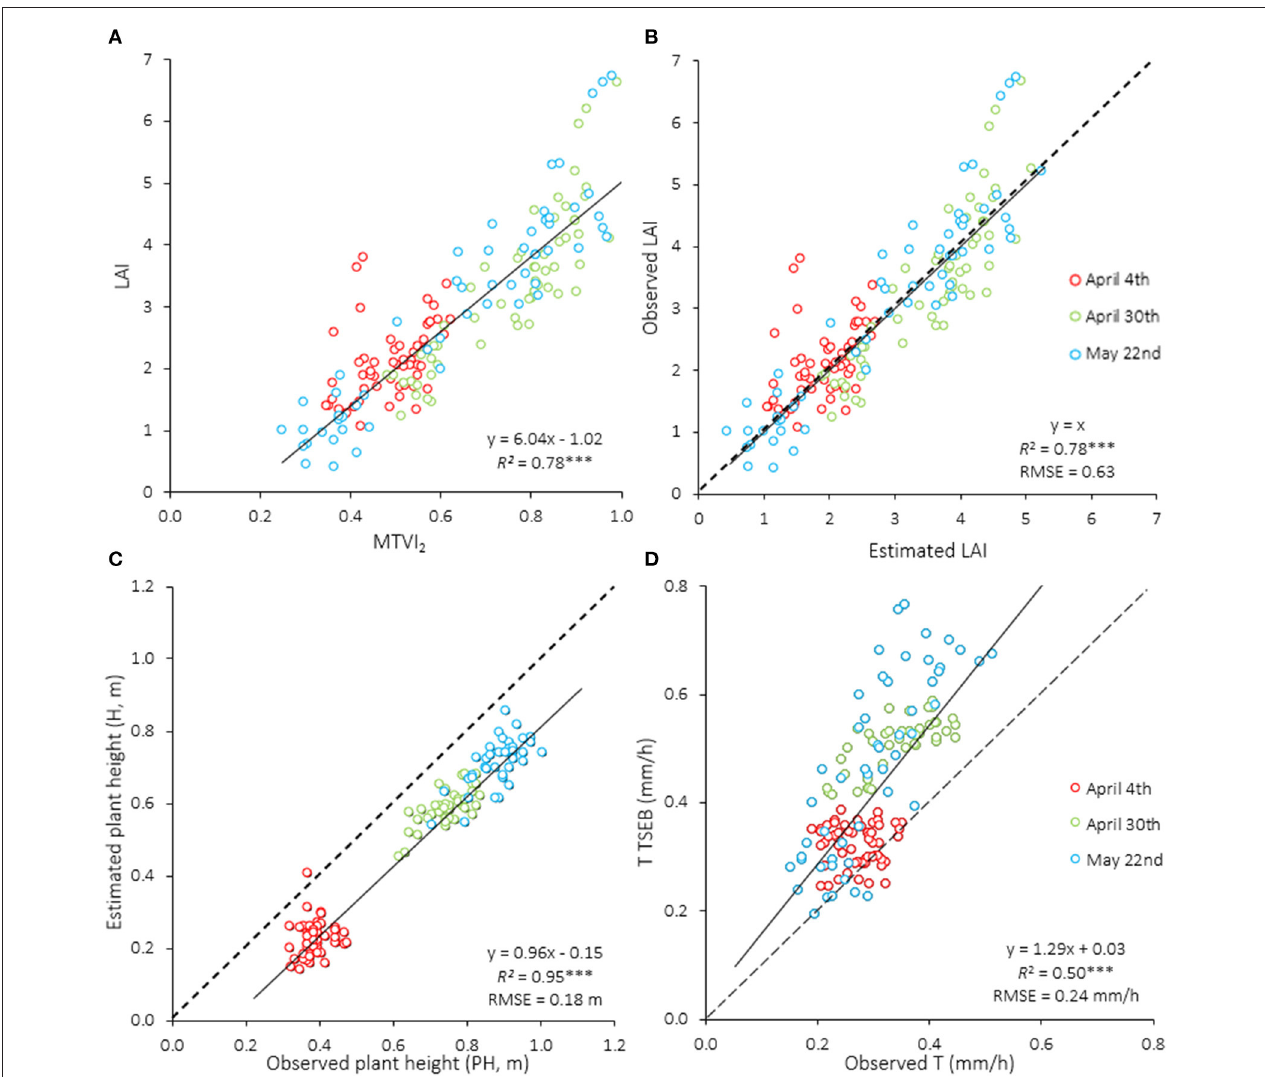
FIGURE 6 | Relationships between (A) leaf area index (LAI) and the MTVI 2 spectral vegetation index, (B) observed and estimated LAI by the MTVI 2 , (C) observed and estimated plant height by the photogrammetric 3D point cloud, and (D) observed leaf transpiration with the IRGA device and estimated plant transpiration (T) through the TSEB model. Different colors indicate different dates of image acquisition ( n 171). RMSE, root mean square error. *** P < 0.001; ** P < 0.01; * P < =